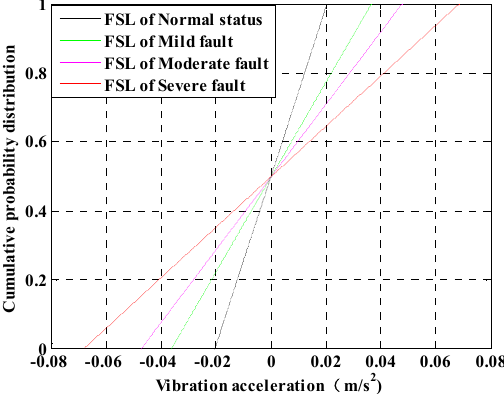
Figure 5. Transformer vibration signal cumulative probability distribution function FSL diagram.